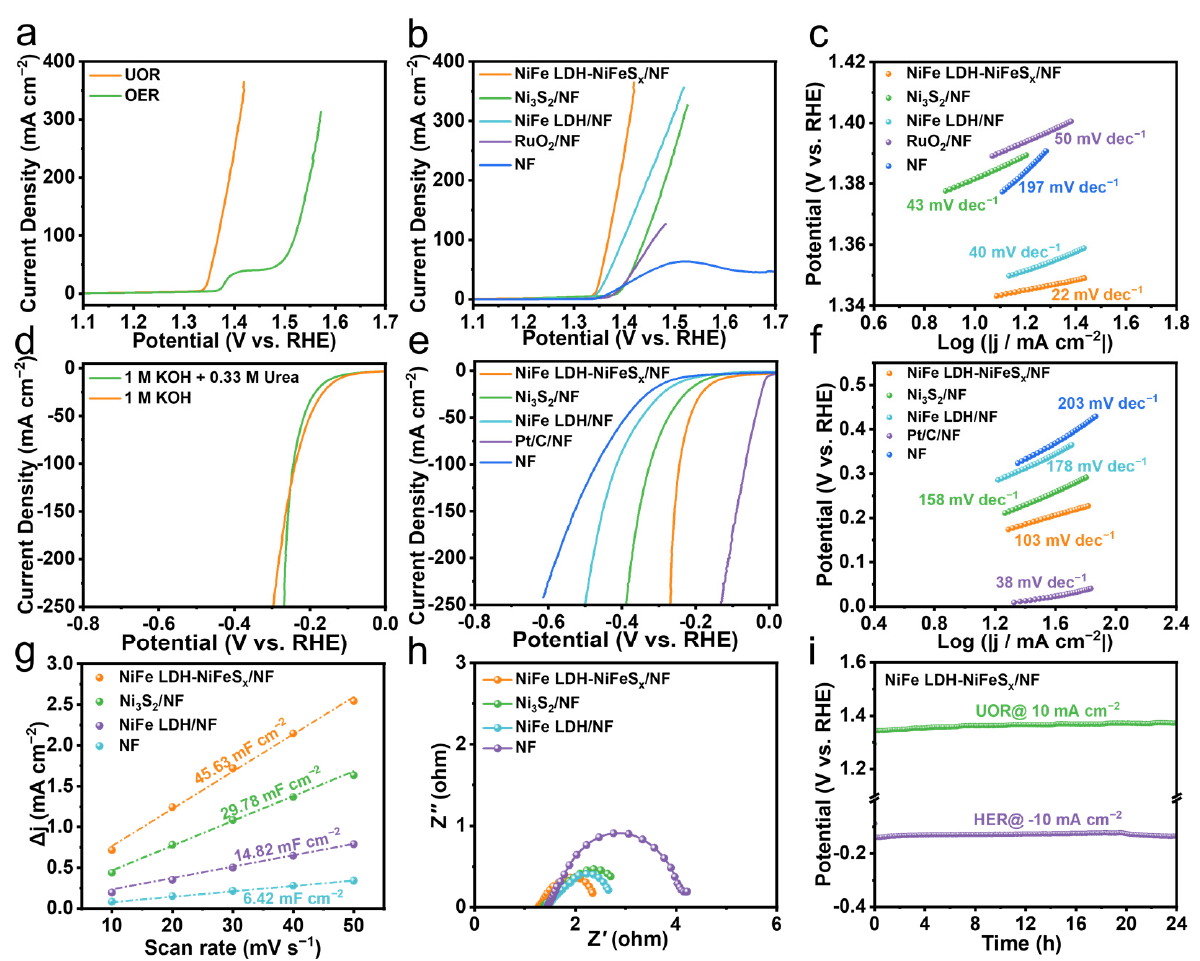
Figure 3. ( a ) UOR and OER LSV curves of NiFe LDH-NiFeS x /NF in the electrolytes 1 M KOH with 0.33 M Urea, and 1 M KOH. ( b ) UOR LSV curves and ( c ) the corresponding Tafel slopes. ( d ) HER LSV curves of NiFe LDH-NiFeS x /NF in different electrolytes. ( e ) HER LSV curves, ( f ) the corresponding Tafel slopes, ( g ) the C dl values, ( h ) Nyquist plots, and ( i ) HER and UOR chronopotentiometry curves in 1 M KOH and 0.33 M Urea.